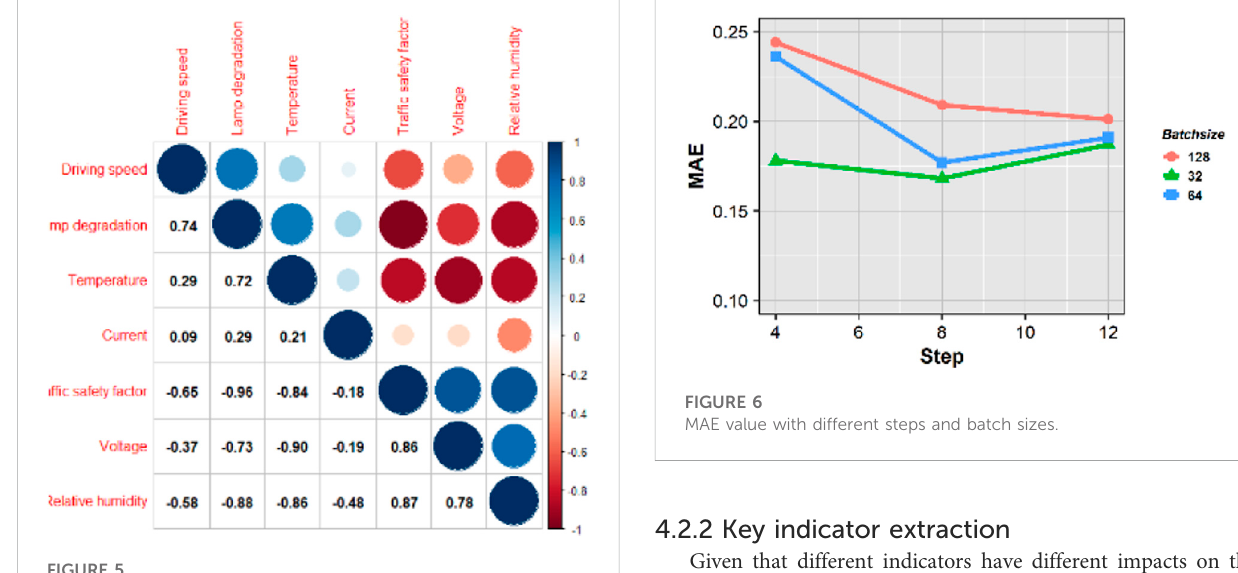
FIGURE 5 Correlation coef fi cient of each indicator.